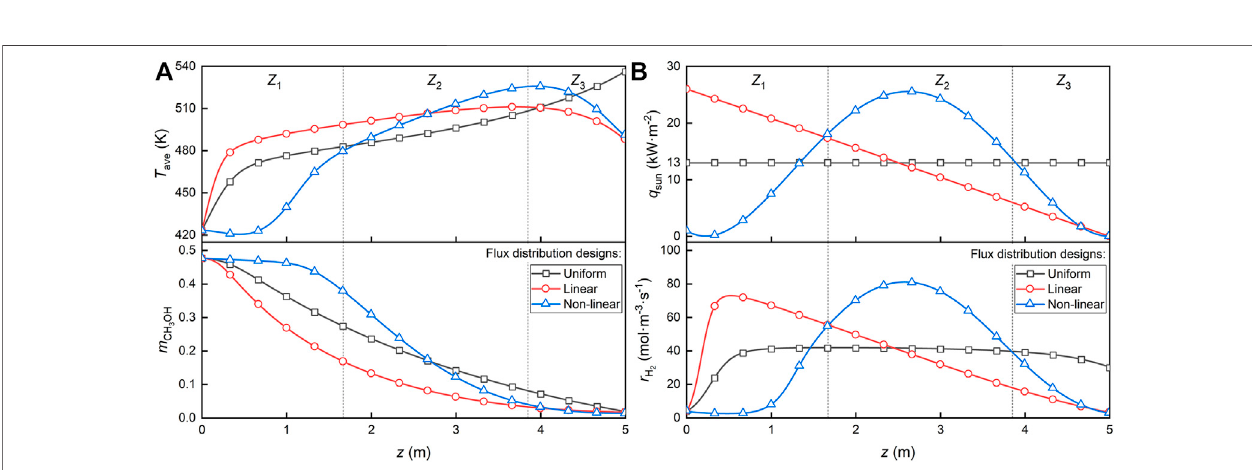
FIGURE7| Distributionoftheaveragevaluesofthevariablesalongthe fl owdirection. (A) Temperatureandmethanolmolarfractionand (B) solar fl uxandhydrogen generation rate.